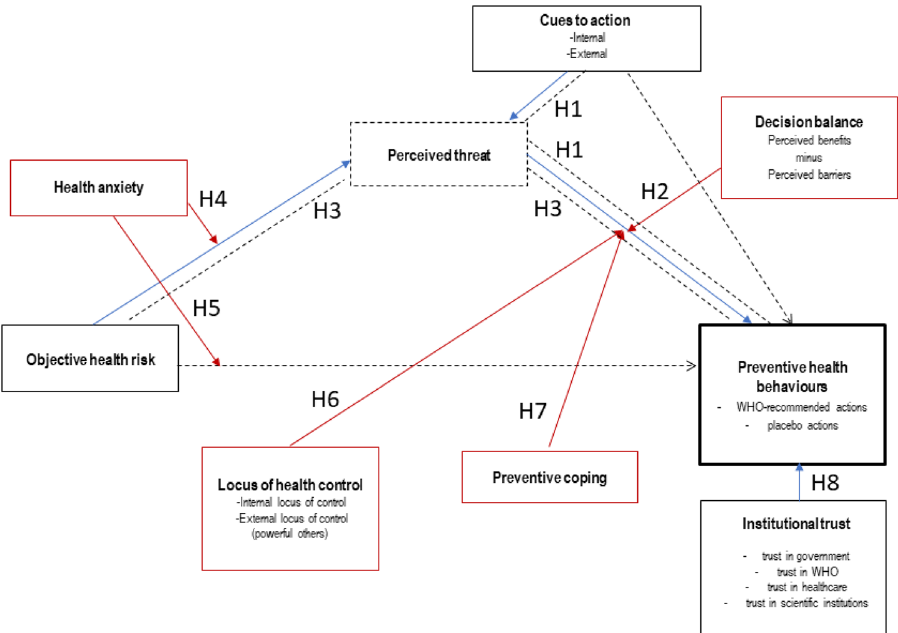
Figure 1. Hypothesized model. The model includes the following predictors: perceived threat of the COVID- 19 disease (perceived susceptibility to infection and perceived severity of COVID-19), objective health risk (risk of developing serious symptoms of COVID-19), cues to action (internal and external cues that motivate an individual to act), decision balance (perceived barriers minus perceived benefits of action), individual characteristics (locus of health control, health anxiety and preventive coping style), institutional trust (including trust in government, WHO, healthcare and scientific institutions). Blue arrows represent direct effects. Moderators are represented by red rectangles; red arrows represent moderation effects. Dotted lines and dotted rectangles represent indirect effects and mediators,